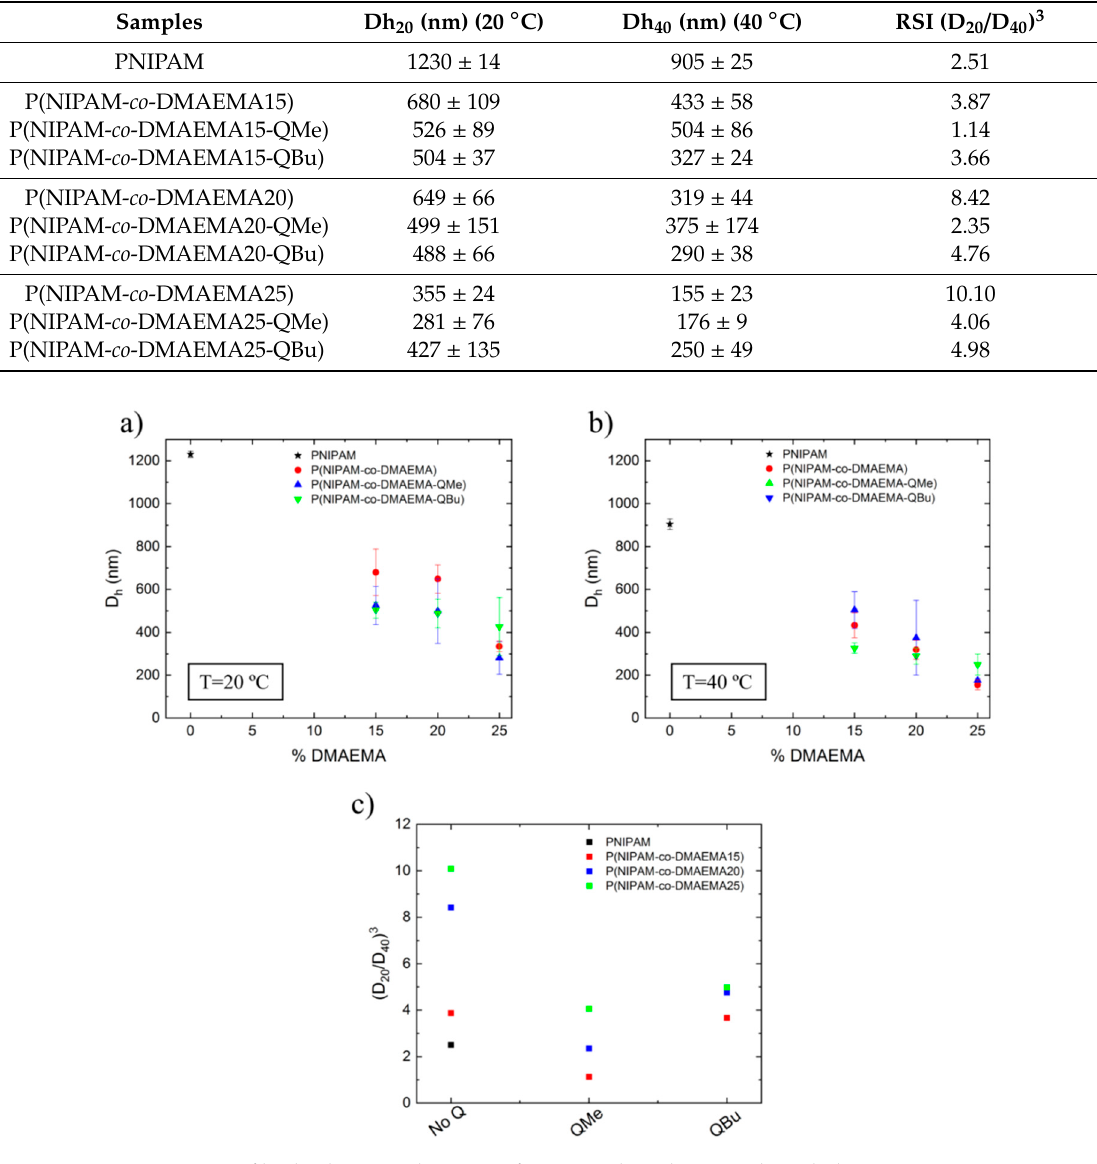
Figure 5. Variation of hydrodynamic diameter of PNIPAM based microgels with the DMAEMA content measured at ( a ) 20 °C and ( b ) 40 °C and ( c ) evolution of the relative swelling index ((D 20 /D 40)3 ) for unquaternized and quaternized with methyl iodide (QMe) and butyl iodide (QBu) microgels.